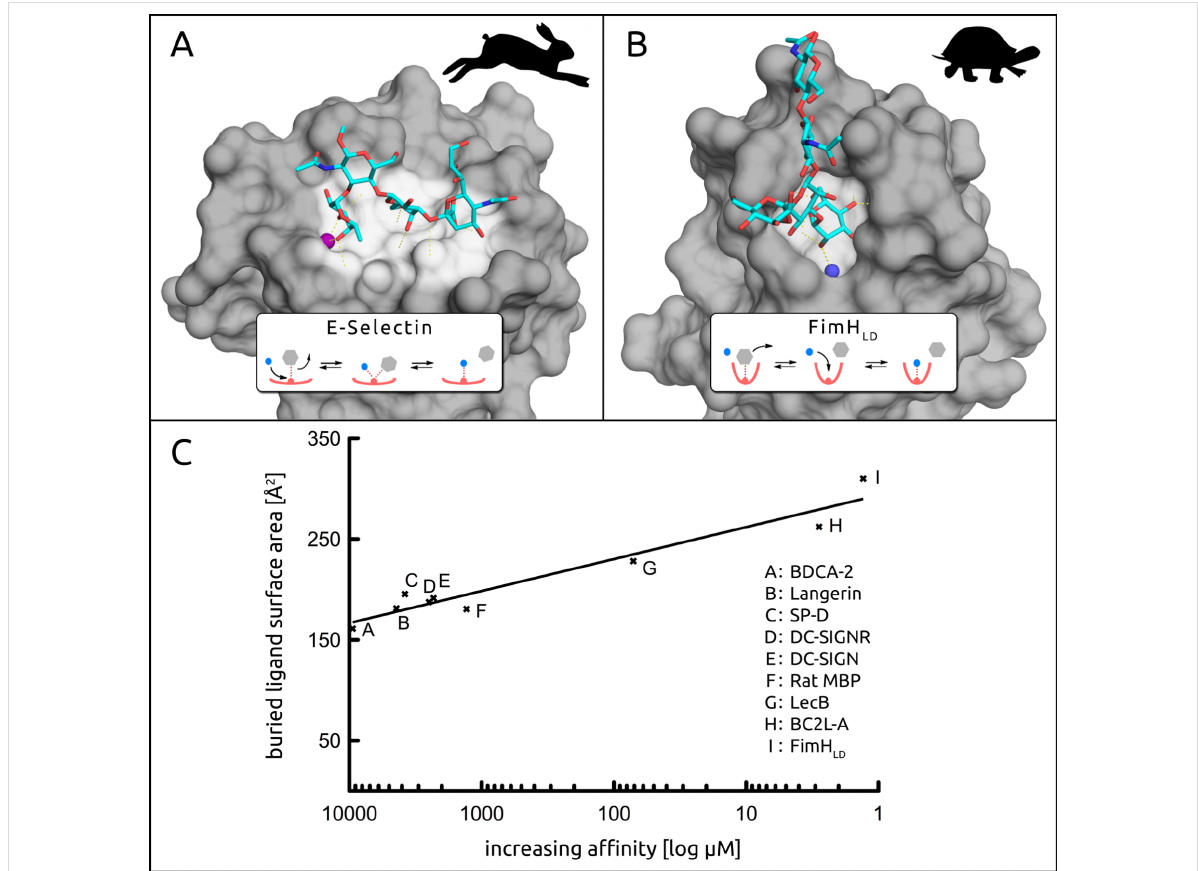
Figure 2: A) The solvent exposed binding site of E-selectin interacting with sLe x (PDB: 1G1T) [53]. B) The buried binding site of FimH LD in complex with a high-mannose epitope and a conserved water (blue sphere) (PDB: 2VCO) [36]. C) The buried ligand surface area of analyzed crystal struc- tures correlates to affinity [ μ M] on a logarithmic scale (for references see Table 1). The rabbit and turtle metaphor was adapted from Schmidtke et al. [50].